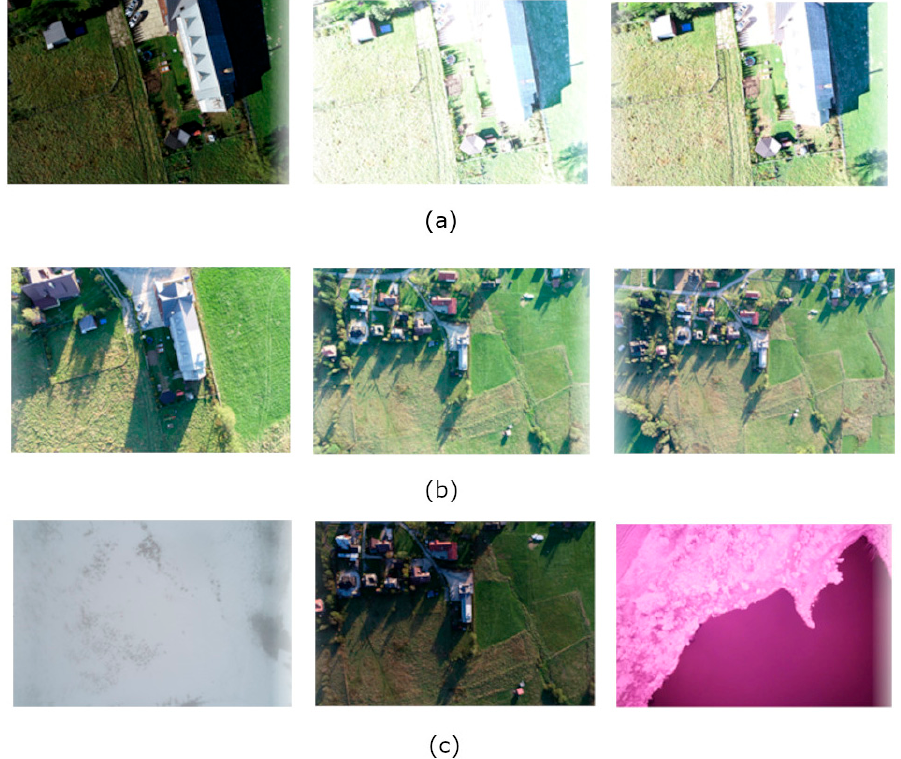
Figure 3. Examples of UAV images ( a ) same area and different exposure conditions; ( b ) same exposure conditions and different altitudes; ( c ) different land cover types and different detector sensitivity ranges (from left: snow-RGB camera, meadows and buildings-RGB camera, water and trees-RGNIR camera).